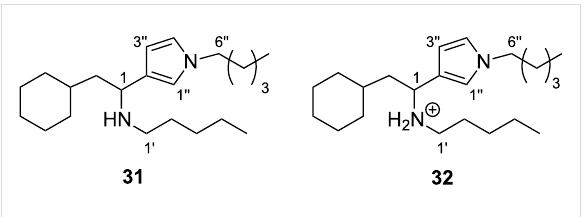
Figure 4: Pyrrole product 31 and salt 32 obtained from reaction of dialdehyde 15 with n